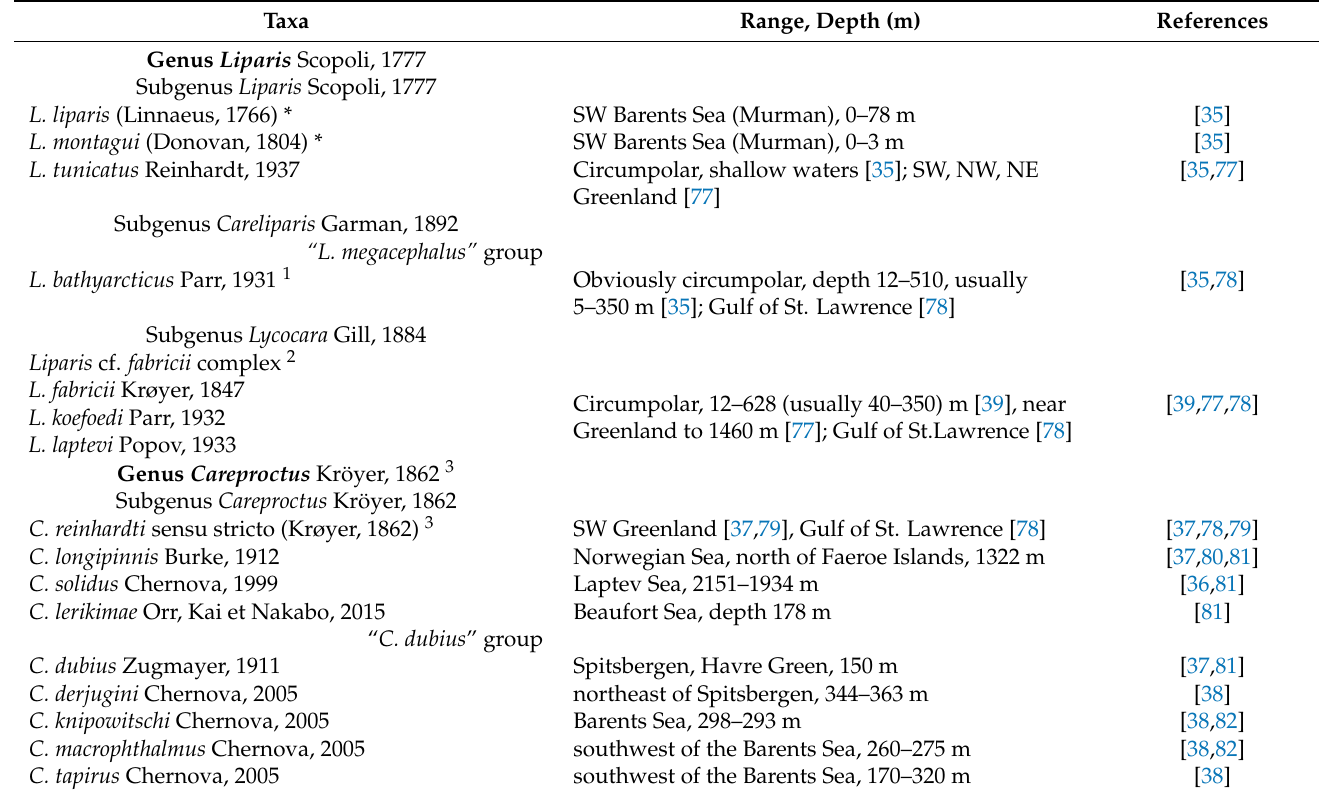
Table 2. List of Liparidae of the Arctic (including those entering marginal areas from the Atlantic). Taxa Range, Depth